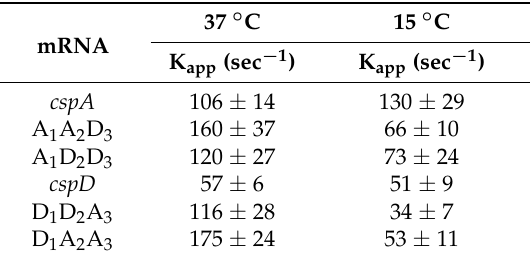
Table 1. Apparent rate constants (K app ) of f[ 35 S]-Met-tRNA binding to 30S-IFs-mRNA complexes at the indicated temperatures.